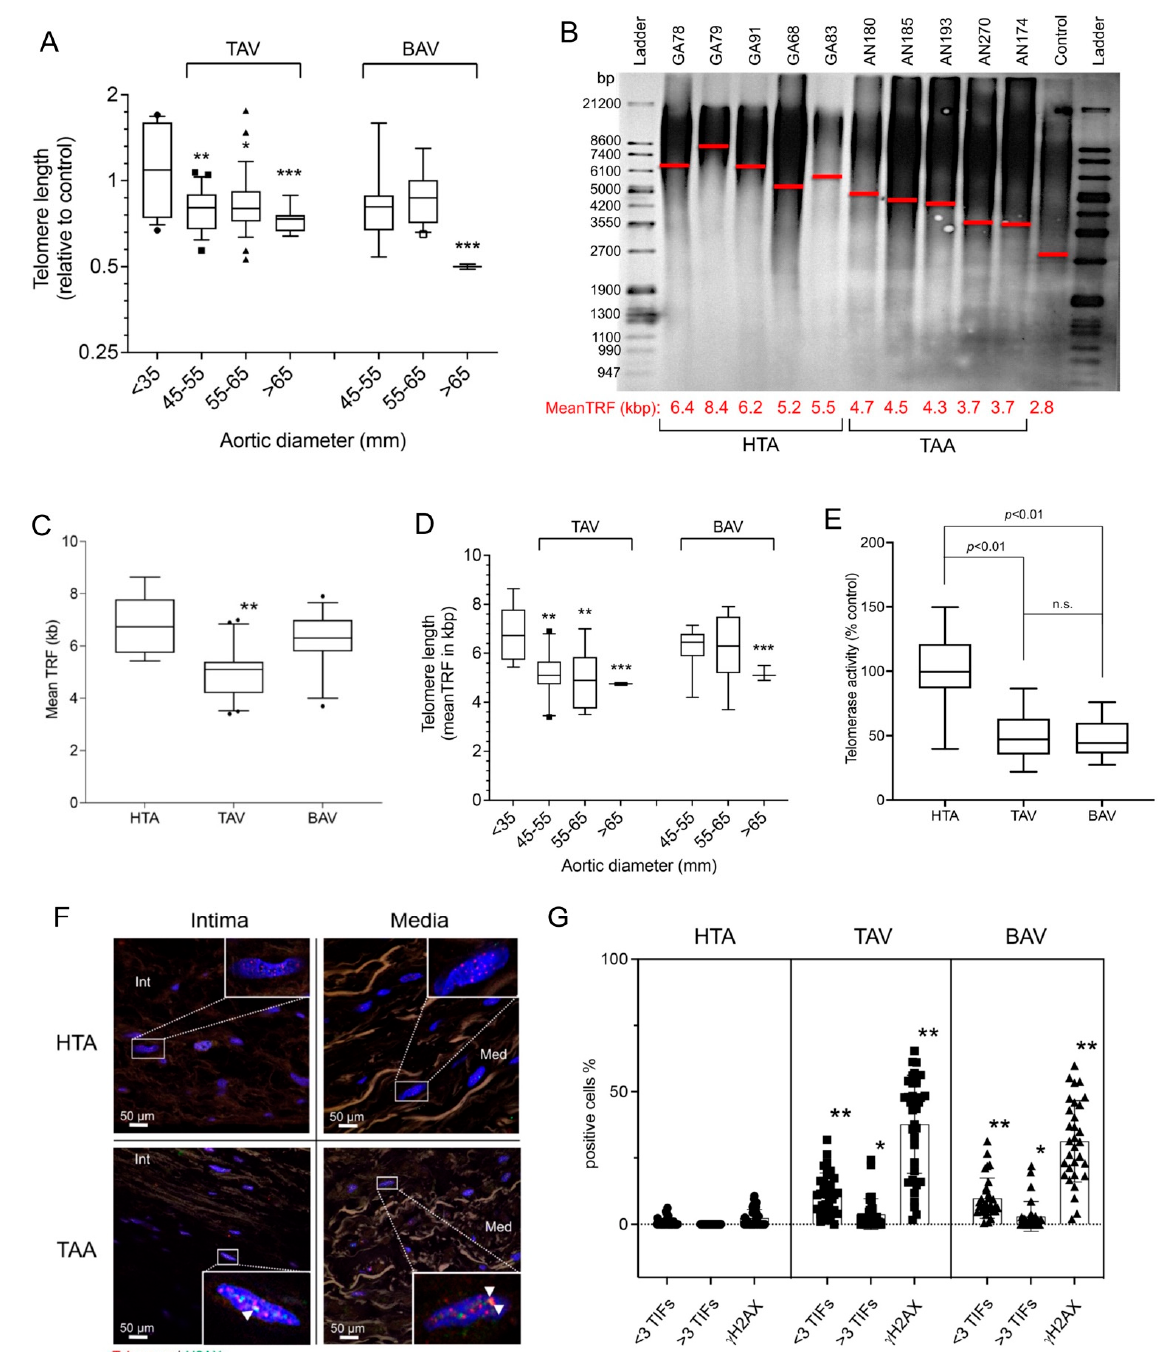
Figure 1. Increase in telomere damage and shortened telomeres in thoracic aortic aneurysm. Measurement of telomere length (TL) in healthy and diseased aortic tissues showed a significant shortening of telomeres and an increase in telomere-specific DNA damage. ( A – D ) Measurement of telomeres was performed by relative qPCR method and quantitative Southern blot method. ( A ) Statistical analysis of qPCR measurement from the two groups TAV (tricuspid aortic valve ( n = 109)) and BAV (bicuspid aortic valve, ( n = 65)) compared to healthy aortic specimens (<35 mm, ( n = 41)). The x-axis shows the individual sizes of the aortic tissues at the time of surgery. Specific analysis of TL in kilobase pairs (kbp) was carried out using Southern blot analysis (HTA samples, n = 16, TAA samples, n = 44). ( B ) shows a representative blot of the measurements. HTA, human thoracic aorta; TAA, thoracic aortic aneurysm. Mean TRF is shown in kbp along the x-axis and marked as a red line in the